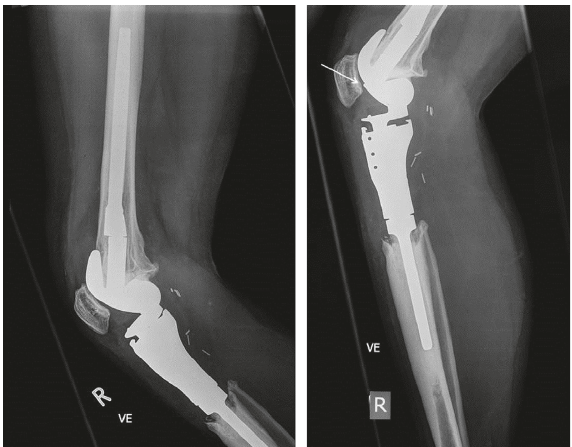
Figure 1: X-rays of the right knee with distal femur and proximal tibia in June 2015. Left (AP view): some bone resorption at the prosthesis-tibia interface. Intact, well-fixed prosthesis. Right: lateral X-rays demonstrated a small step (arrow) of the lateral femur condyle of the prosthesis.